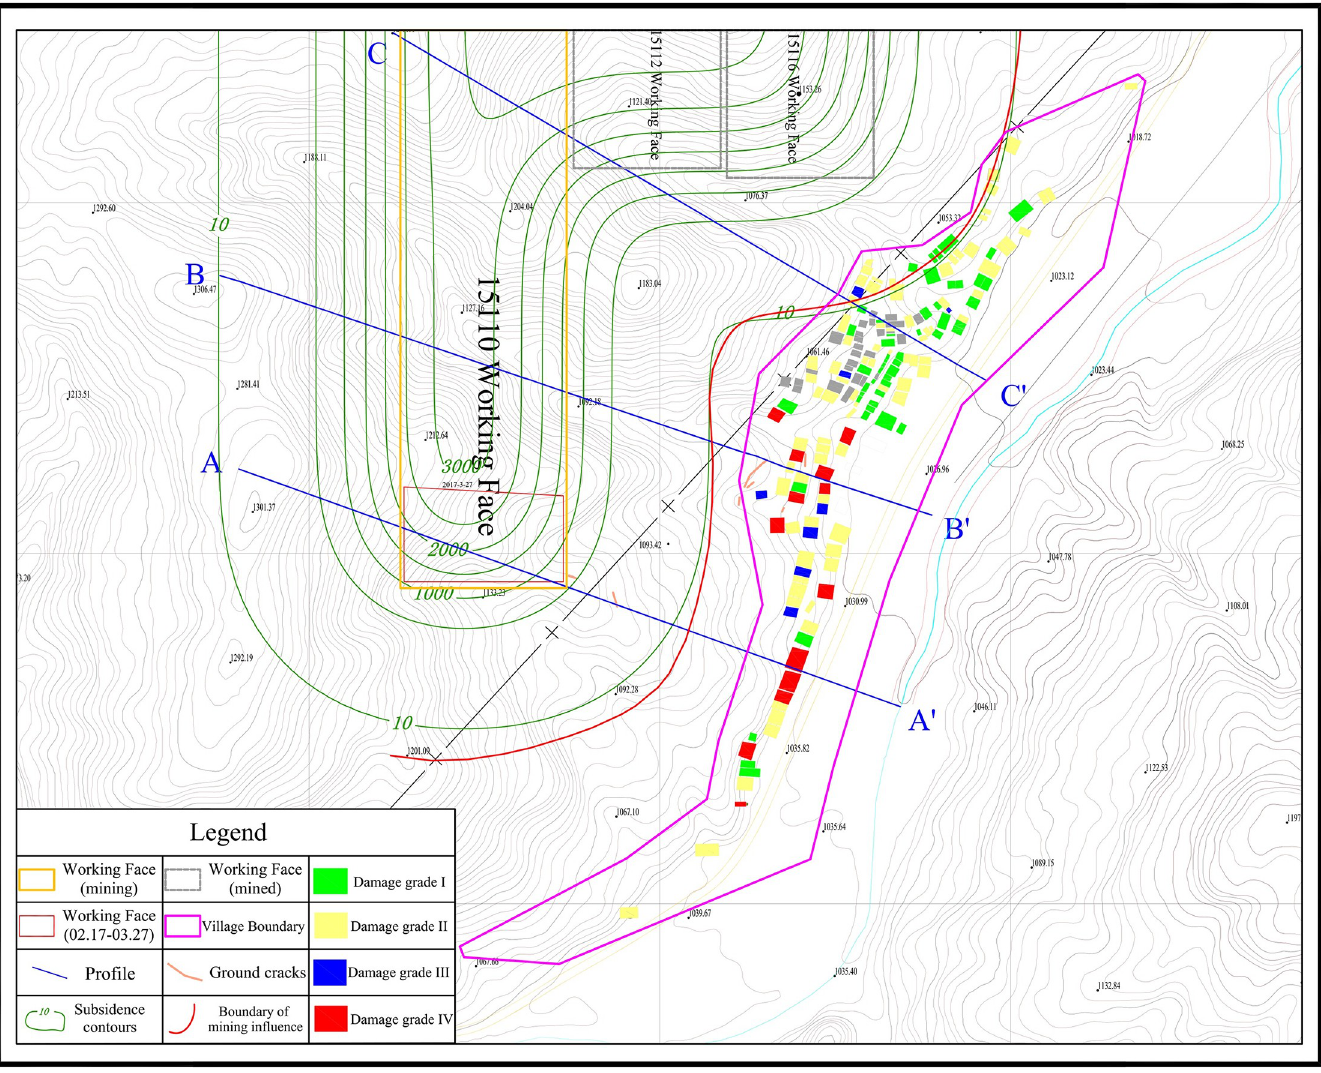
Fig 1. Location of the study